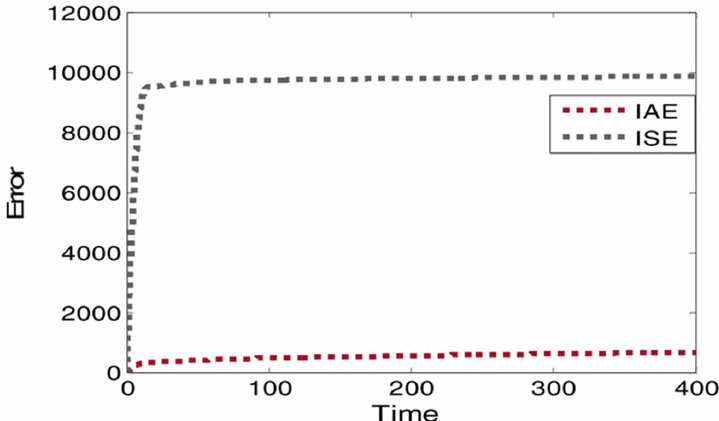
Figure 14. Ambulance error response with fractional-order PID in terms of time and error.